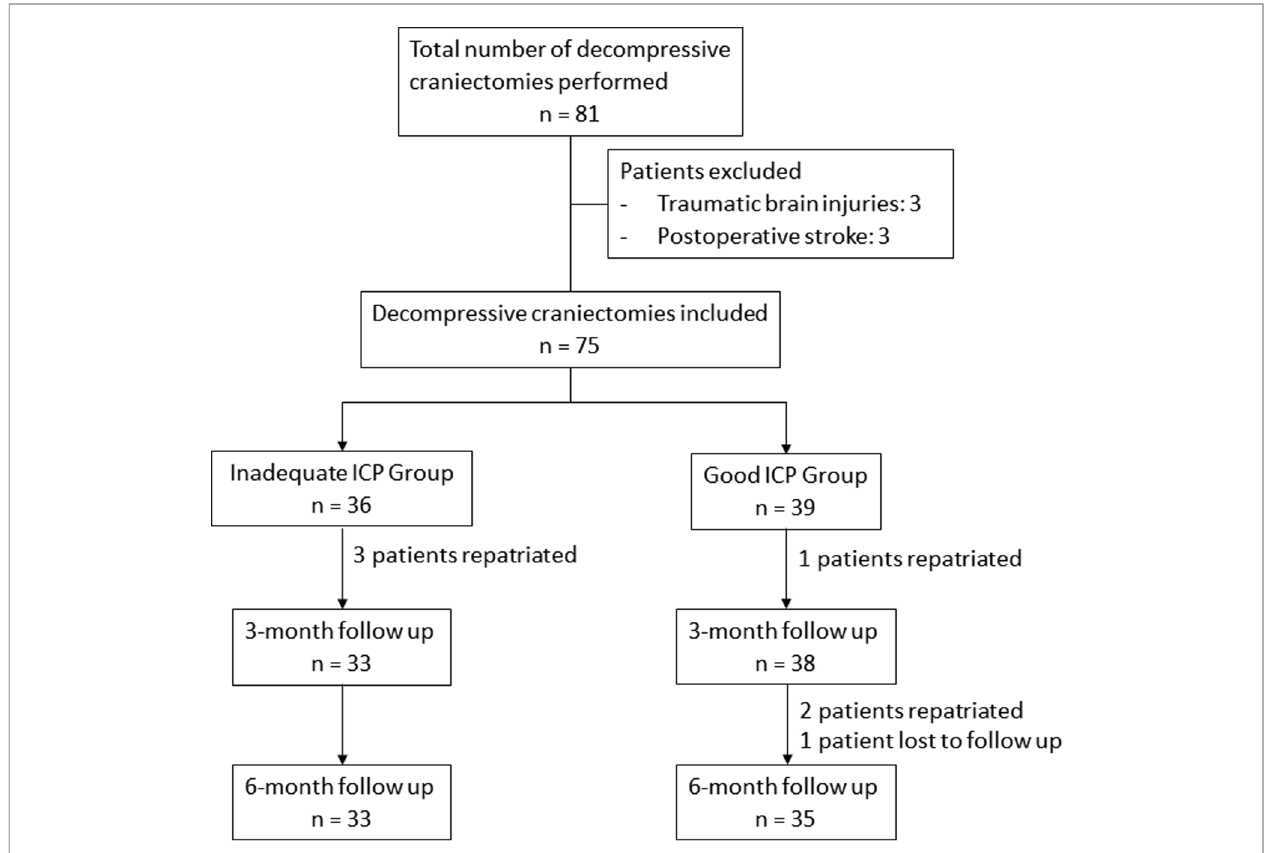
FIGURE 1 | Flowchart of patients at various timepoints. Outcome evaluation of decompression at 3 and 6-month follow up.